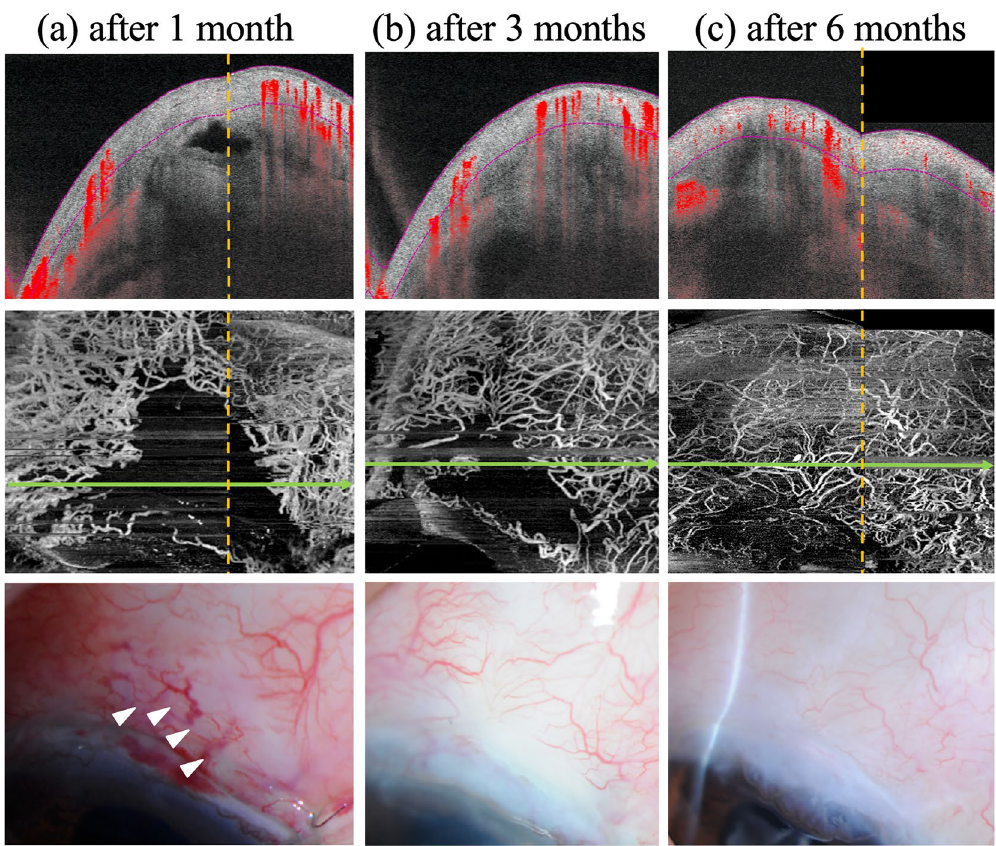
Figure 3. A case with discrepancy between AS-OCTA and slit-lamp microscopy findings. Cross-sectional OCTA images overlying the B-scan images (upper), AS-OCTA en face images (middle), and slit-lamp microscopy photographs (bottom) at 1 ( a ), 3 ( b ), and 6 ( c ) months postoperatively. The complete avascular area (CAA) decreases as time passes. A marked CAA is observed in the AS-OCTA image at 1 month after surgery ( a , middle), but meandering blood vessel-like structures exist in the slit-lamp microscopy photograph ( a , bottom, white arrowheads).